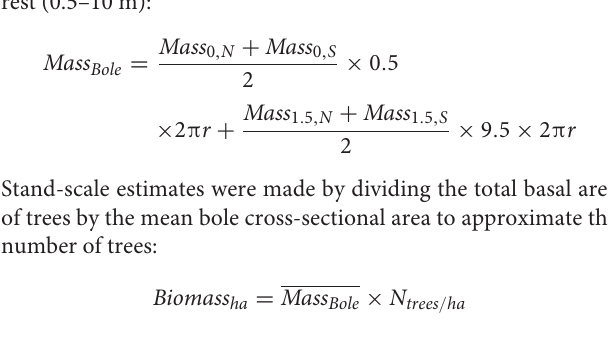
TABLE 2 | Mean attributes of each non-vascular epiphyte functional